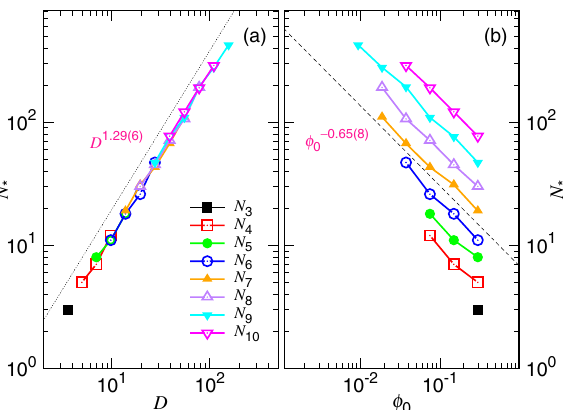
Figure 8. ( a ) Critical monomer number N ∗ as a function of the cavity diameter D for various chain lengths N . ( b ) N as a function of φ 0 for different N . The color legend for N is given in Panel ( a ) where N i ∗